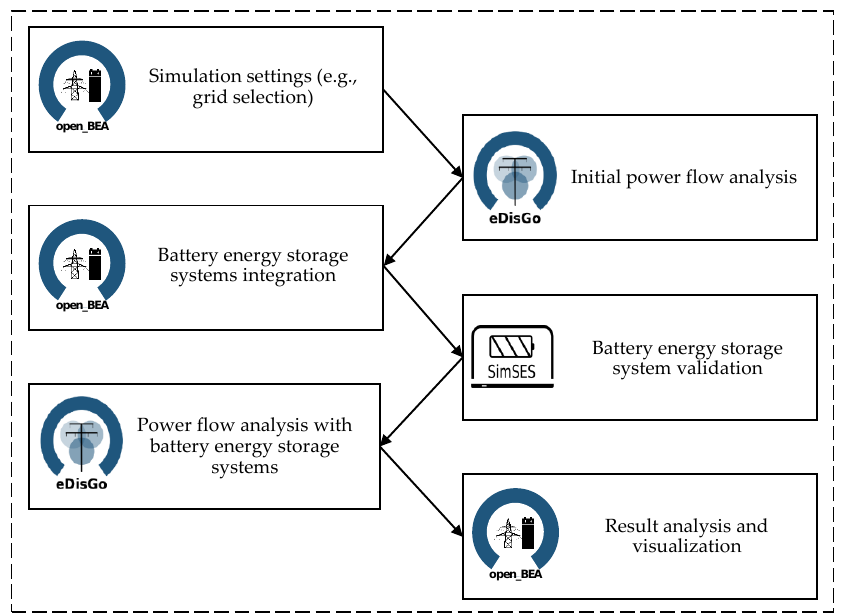
Figure 2. Overview of all open-source simulation tools, which have been adapted for use in this study. The open_BEA tool operates as both a central control unit and as a configuration unit. The eDisGo tool conducts the power flow analysis and SimSES operates as a validation unit for the battery energy storage systems’